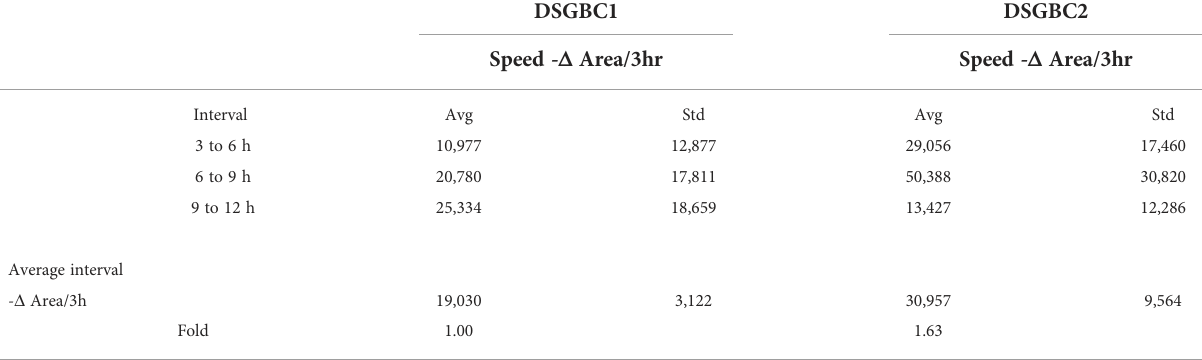
Data represent average +/- standard deviation of the mean, n =